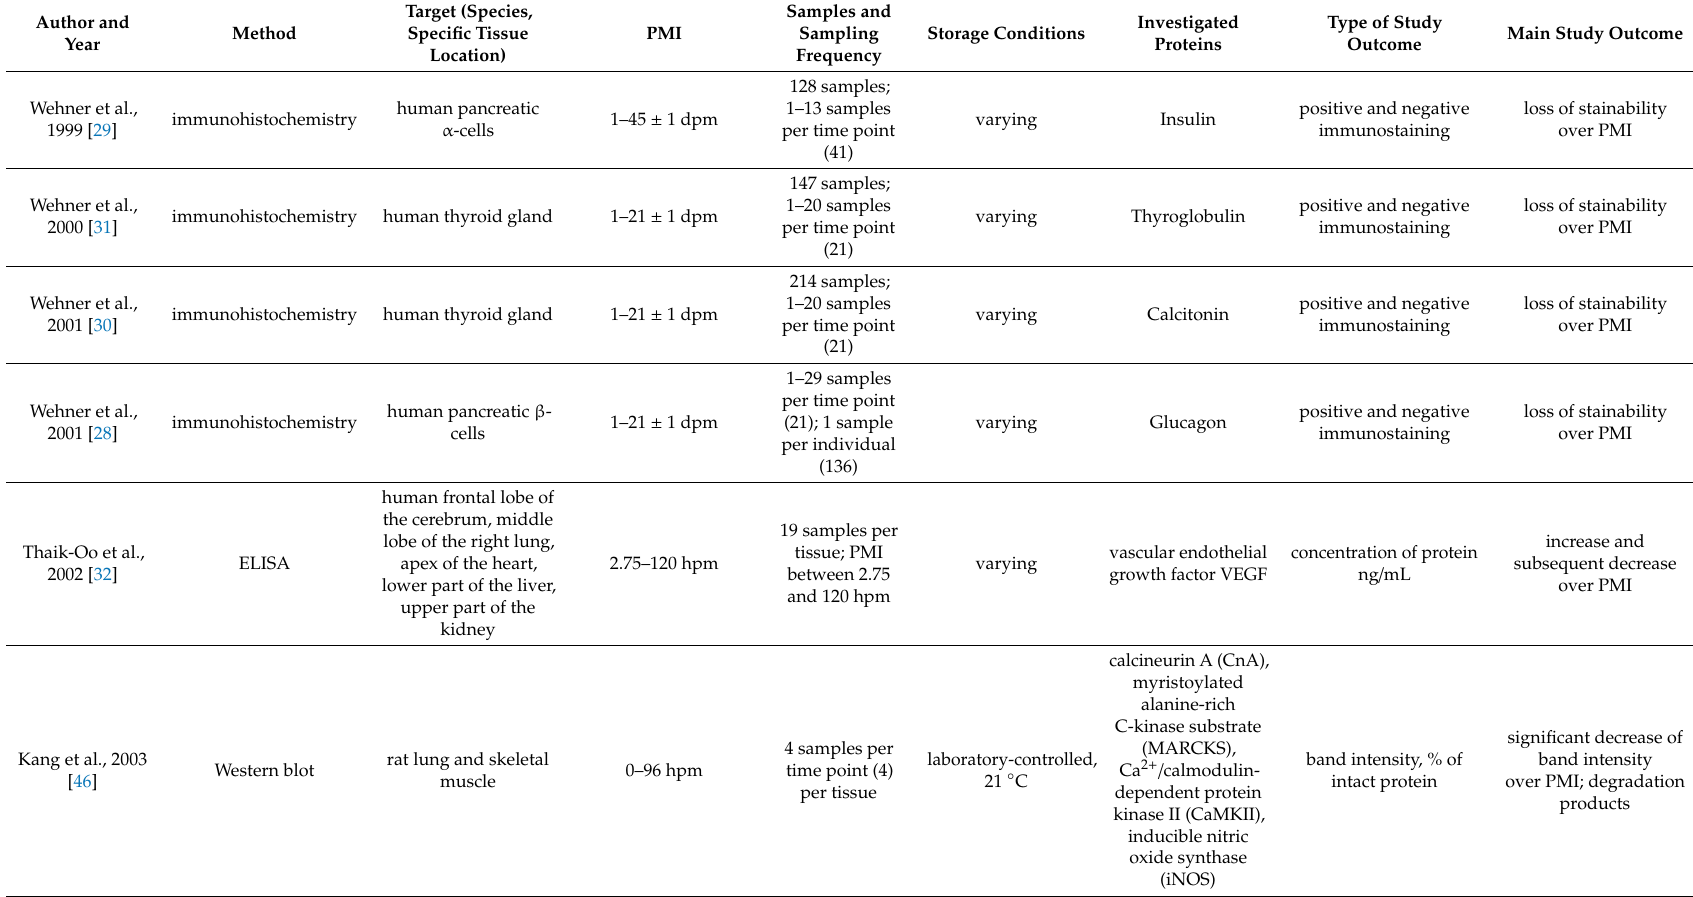
Table 2. Overview of study details and outcome of the 36 included studies. pm: postmortem, dpm: days postmortem, hpm: hours postmortem, ADD accumulated degree